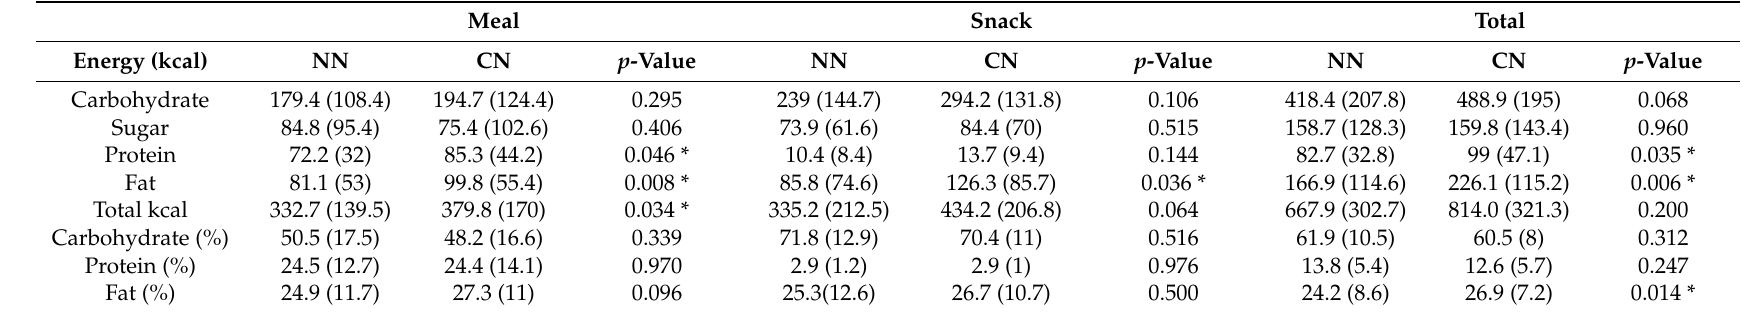
Table 5. Energy and percentage of total energy by macronutrient for normal night sleep and curtailed night